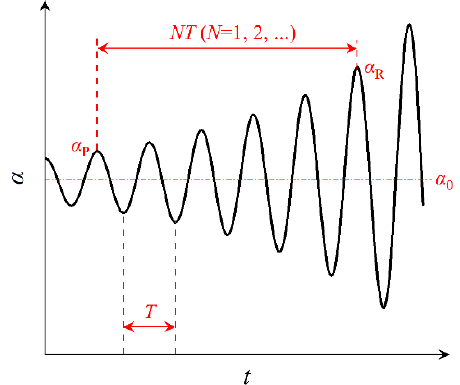
Figure 7. Definition of the damping ratio of torsional self-excited